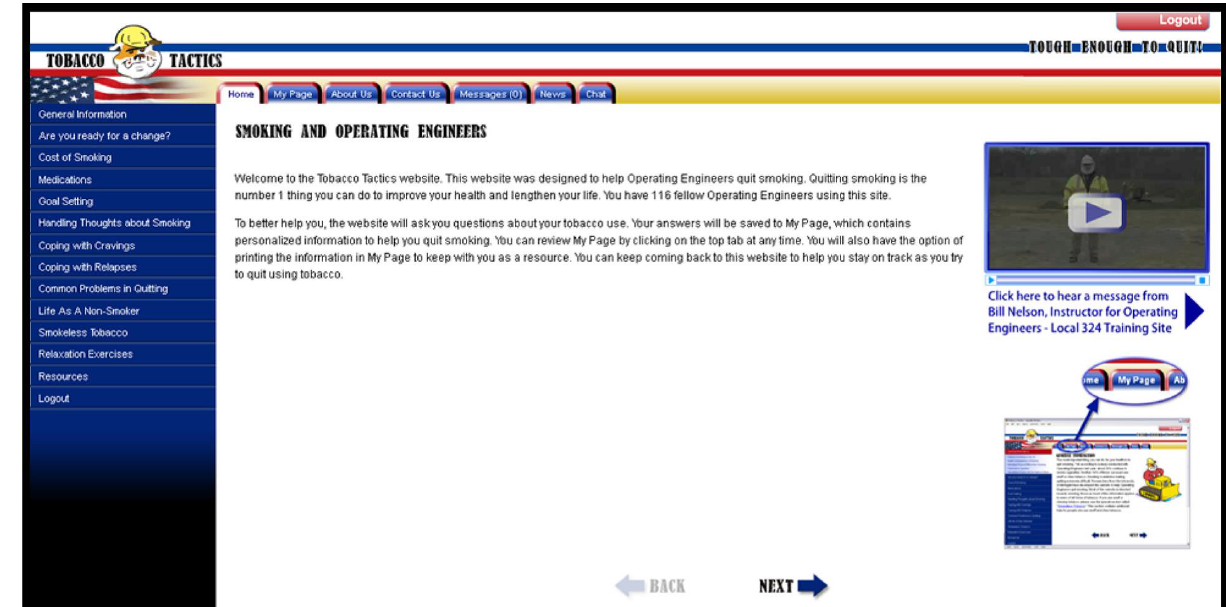
Figure 1. Screenshot of the